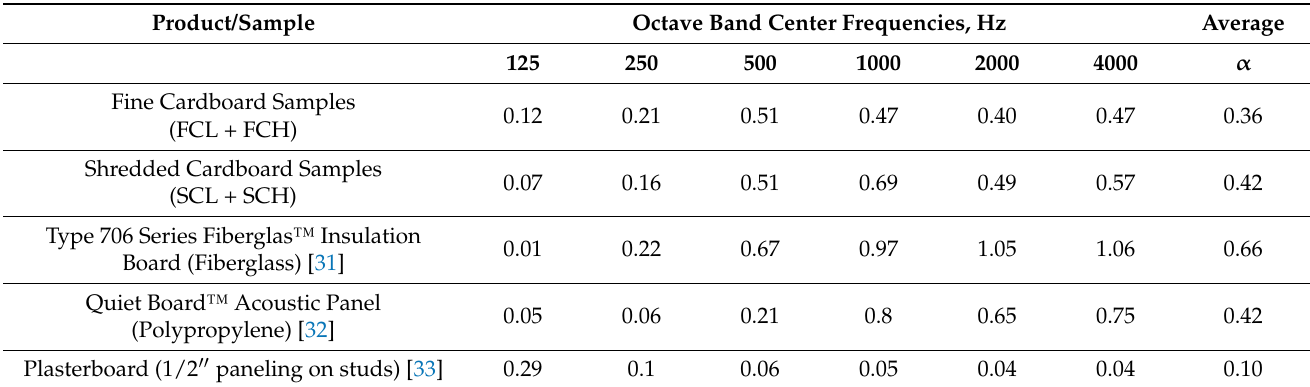
Table 5. Sound Absorption Coefficients comparing commercial sound absorbing materials with